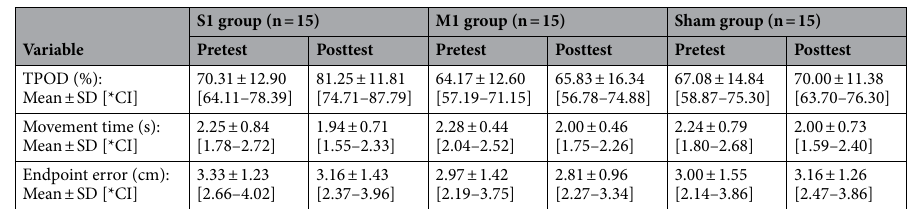
Table 2. Means, standard deviations and confidence intervals of TPOD, movement time and endpoint error of the sensation tasks for stimulation groups in time points. TPOD = Two-point orientation discrimination; S1/M1 group: high-definition transcranial direct current stimulation over S1/M1, respectively. *CI = 95% confidence